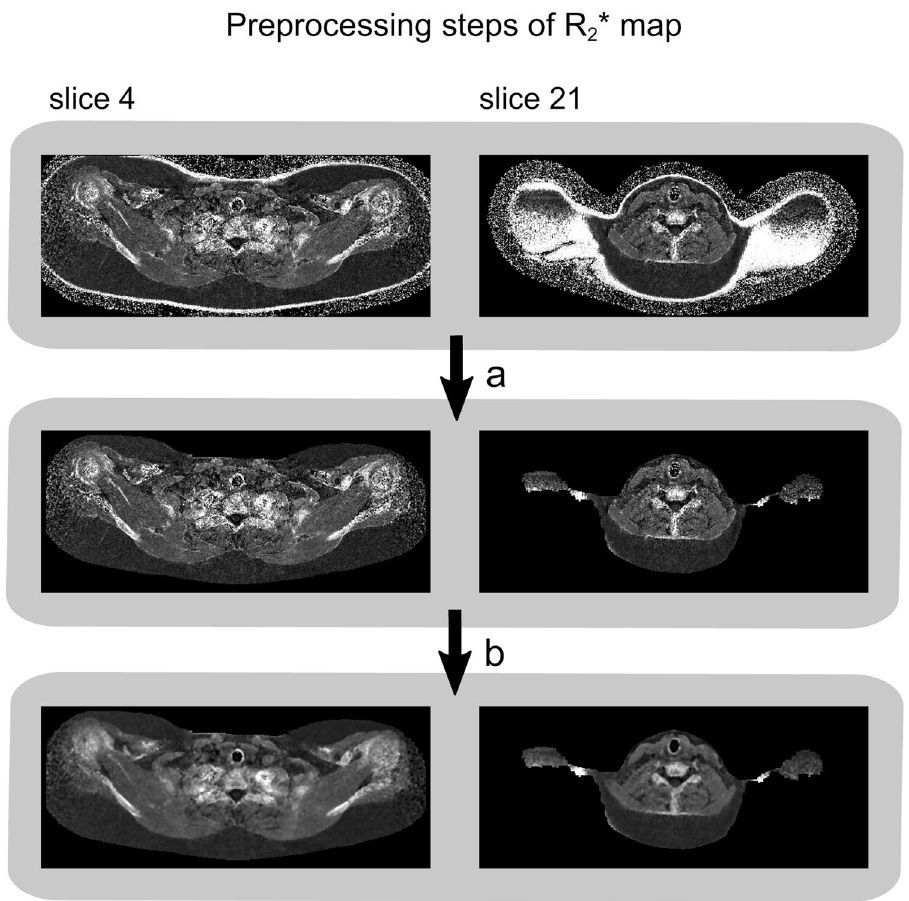
Figure 5. The preprocessing steps applied to the R 2 * map prior to image registration in the multi-atlas segmentation (MAS) method. Two slices of the same subject are illustrated. Step a: Removal of background voxels outside of the body and skin voxels. Step b: Reduction of image noise using a median-filter. The preprocessed R 2 * map exhibited high voxel intensities in areas close to bone and air-filled structures, which guided the matching of these anatomies under image